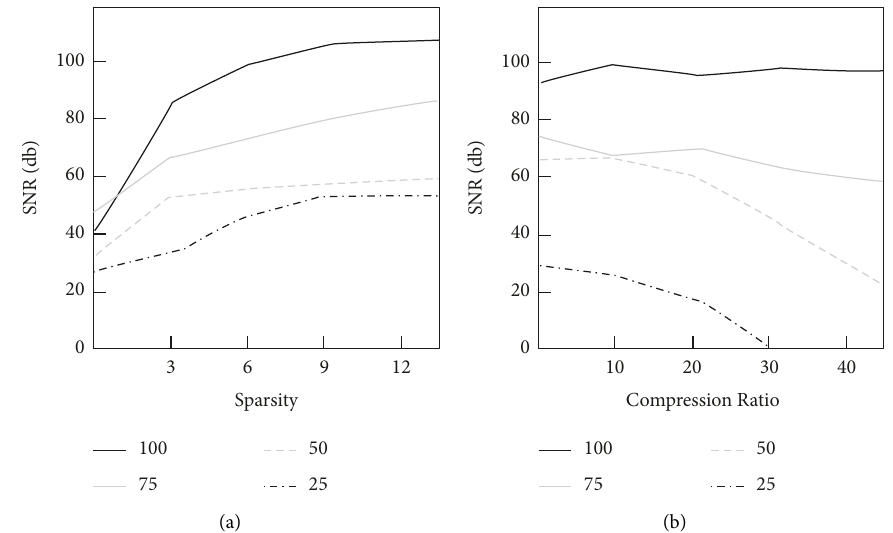
Figure 6: Training learning dictionary performance results graph for different sample numbers. (a) Signal-to-noise ratio at different sparsity. (b) Signal-to-noise ratio at different compression